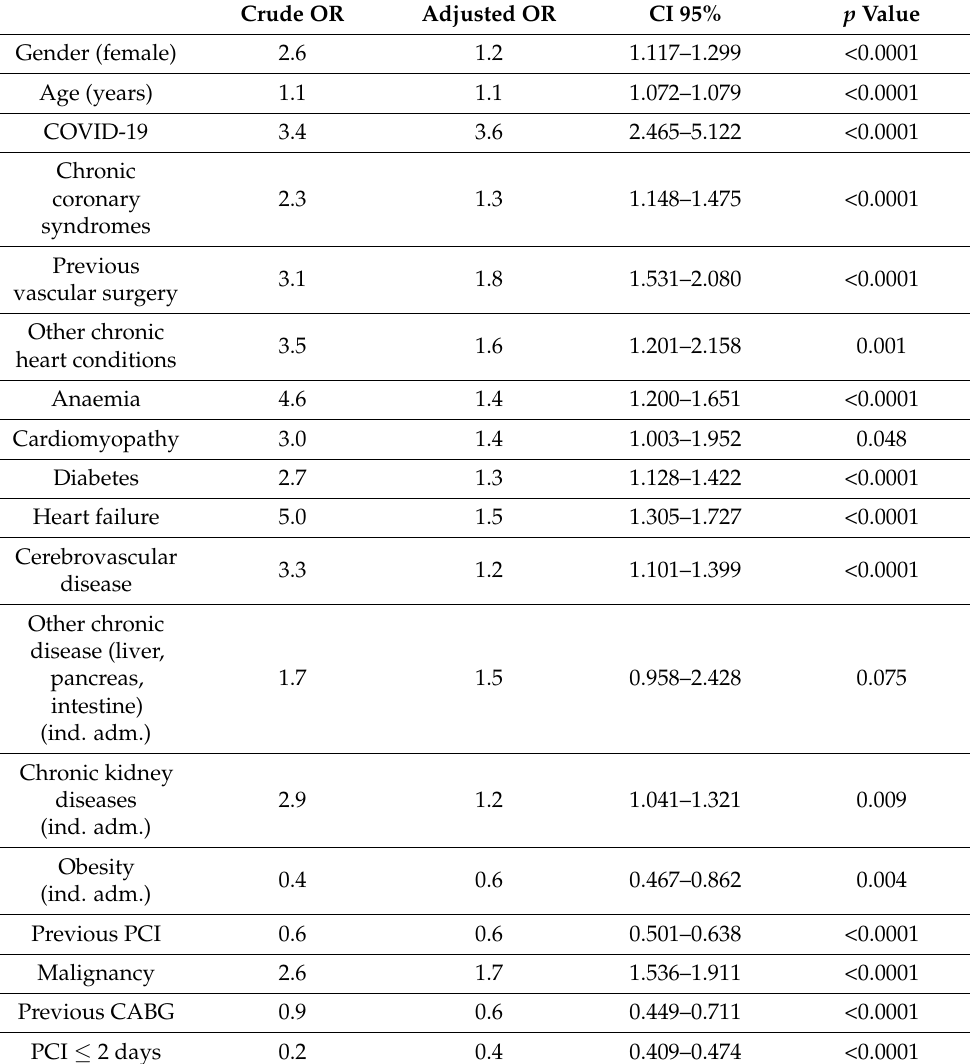
Table 2. Logistic regression model for 6 months